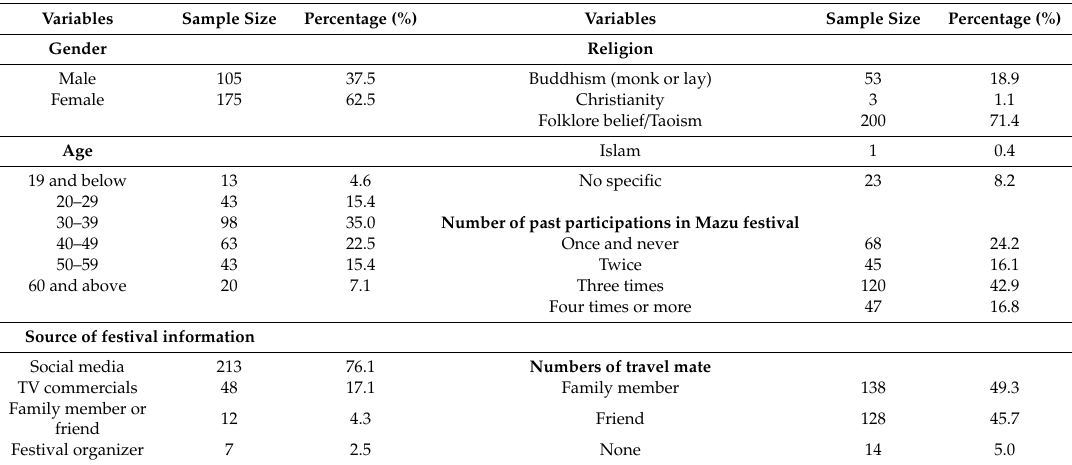
Table 1. Profile of respondents ( n =